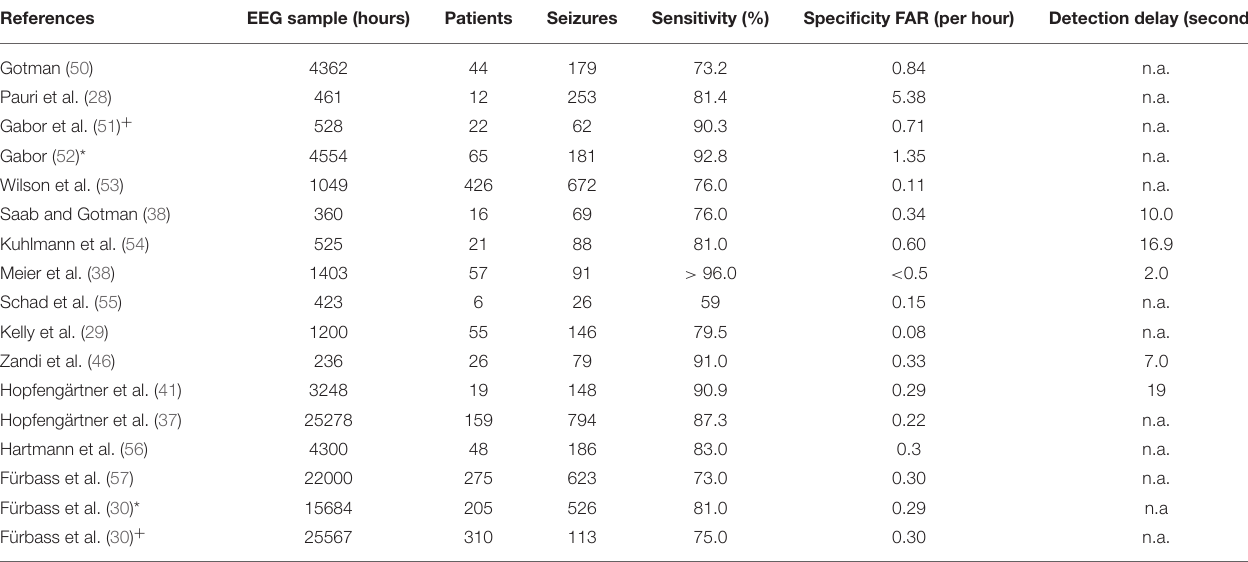
TABLE 2 | Non-patient specific, scalp-EEG based seizure detection algorithms tested in clinical